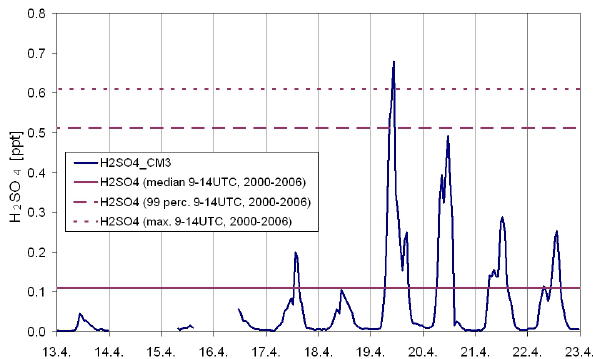
Fig. 6. Size-resolved particle number concentration at the GAW Global Station Zugspitze/Hohenpeissenberg, platform Hohenpeis- senberg at 980m elevation as derived from an optical particle counter